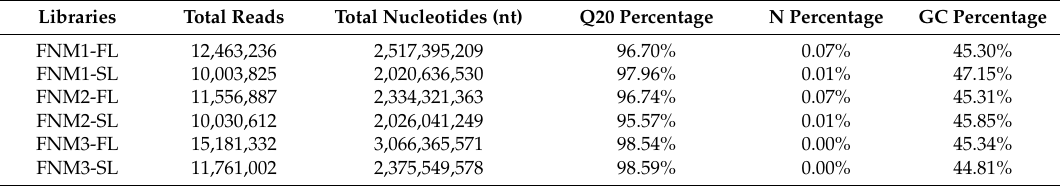
Table 1. Throughput and quality of RNA-seq of the differentially expressed gene libraries.